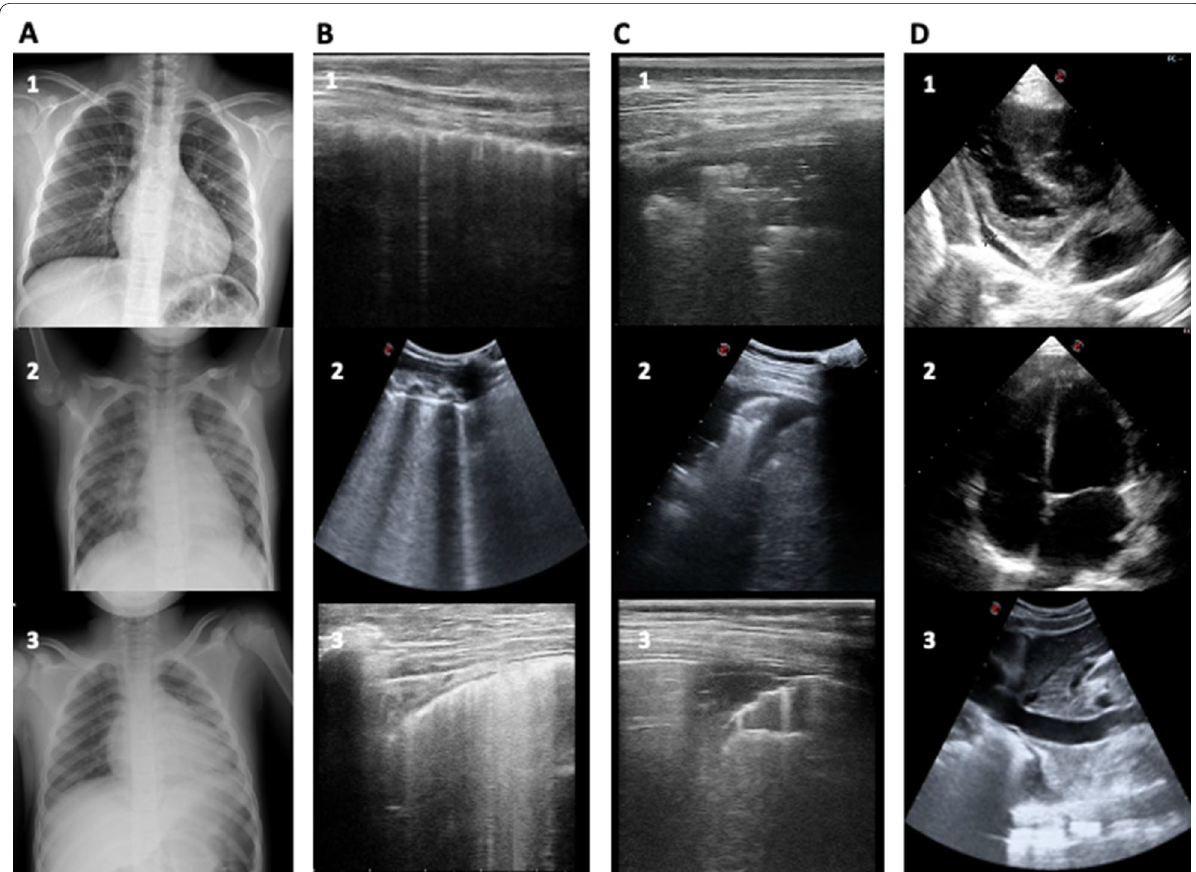
Fig. 2 Imaging findings: A chest X-ray findings; B LUS exam: B1 initial interstitial pattern, B2 vertical artifacts, B3 white lung; C LUS exam: C1 lung consolidations; C2 , C3 lung consolidations with pleural effusion; D RUSH exam: D1 pericardial effusion, D2 dilated cardiac chambers, D3 plethoric